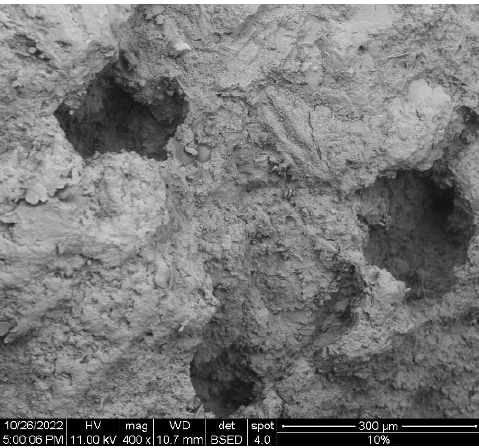
Figure 7. Microporous structure of the sample reinforced with 10% recycled rubber .